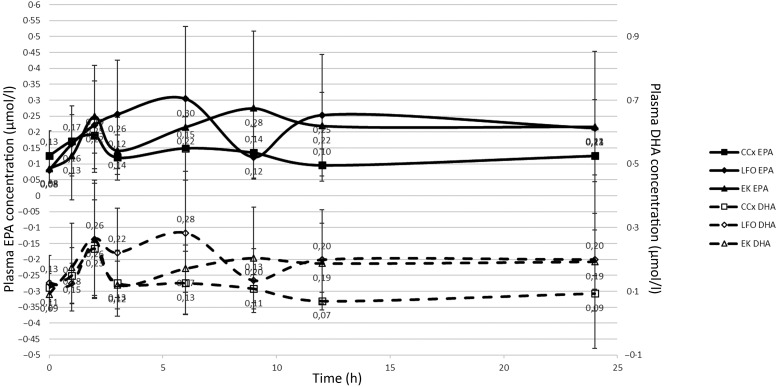
Plasma levels of EPA and DHA during the first 24 h after a single-dose administration for three different matrices (i.e. soft gel tablet (CCx, n 13 dogs), liquid fish oil (LFO, n 9) and enriched kibbles (EK, n 11)) expressed in μmol/l. Values are means, with standard deviations represented by vertical bars.